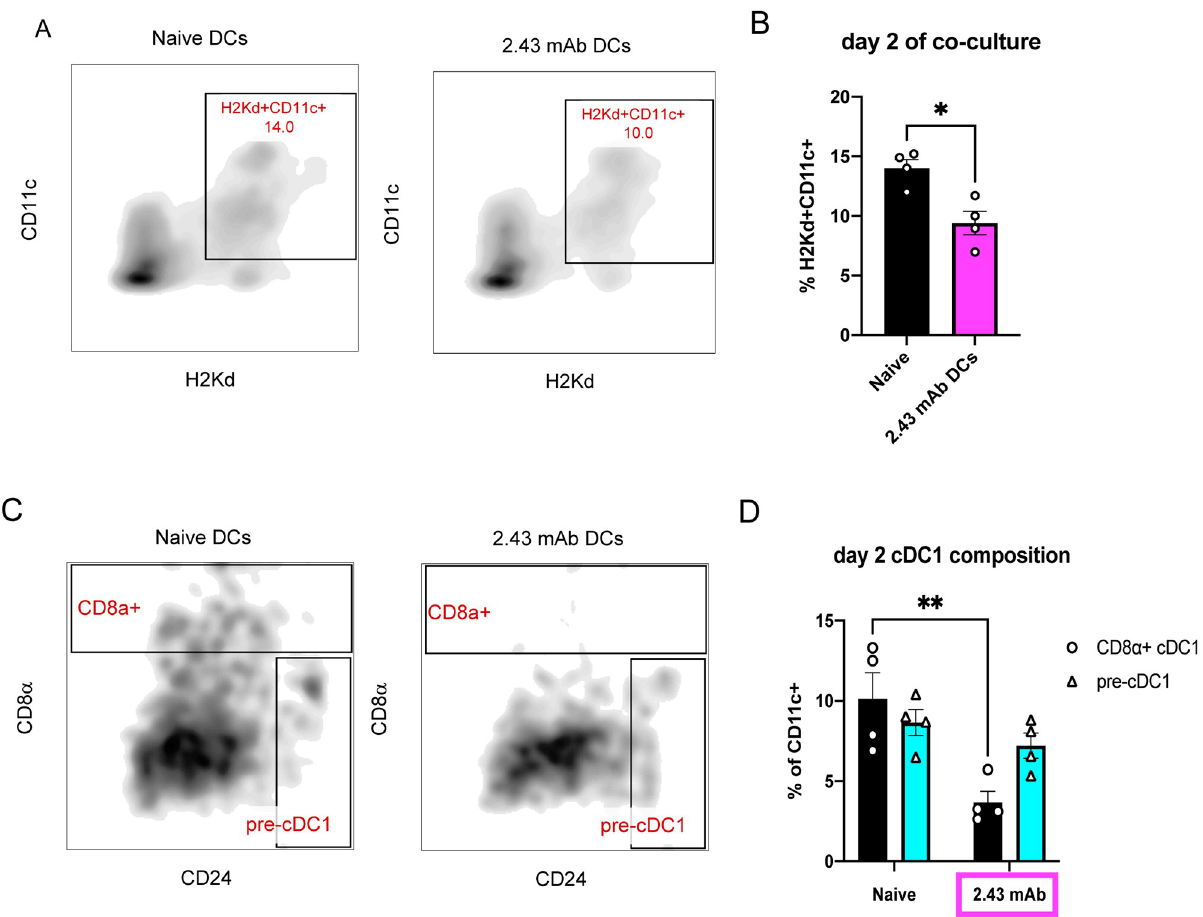
Fig 4. 2.43 mAb-treated DCs retain a lower frequency of CD8 α + cDC1s. BALB/c mice were dosed with 200 μ g of 2.43 mAb antibody intraperitoneally on day -3 and day -1. On day 0, splenic DCs were isolated and plated in an allogeneic MLR. DC composition was determined by flow cytometry on day 2 of co-culture. Data is representative of two independent experiments. (n = 4 per group) (A) Representative flow plots depicting percent of H2K d +CD11c+ DCs in na ï ve DCs (left) and 2.43 mAb DCs (right) on day 2 of co-culture. (B) Mean percent of H2K d +CD11c+ DCs for na ï ve (black) or 2.43 mAb DCs (magenta) shown with SEM. Unpaired t test was used to determine significance between groups. �� P < 0.01. (C) Representative flow plots depicting percent CD8 α + cDC1s and pre-cDC1s in na ï ve (left) and 2.43 mAb DCs (right). (D) Mean percent CD8 α + cDC1s (black bars) and pre-cDC1s (teal bars) in na ï ve and 2.43 mAb DCs shown with SEM. 2way ANOVA and Sˇida´k’s multiple comparison used to determine statistical significance. �� P < 0.01.